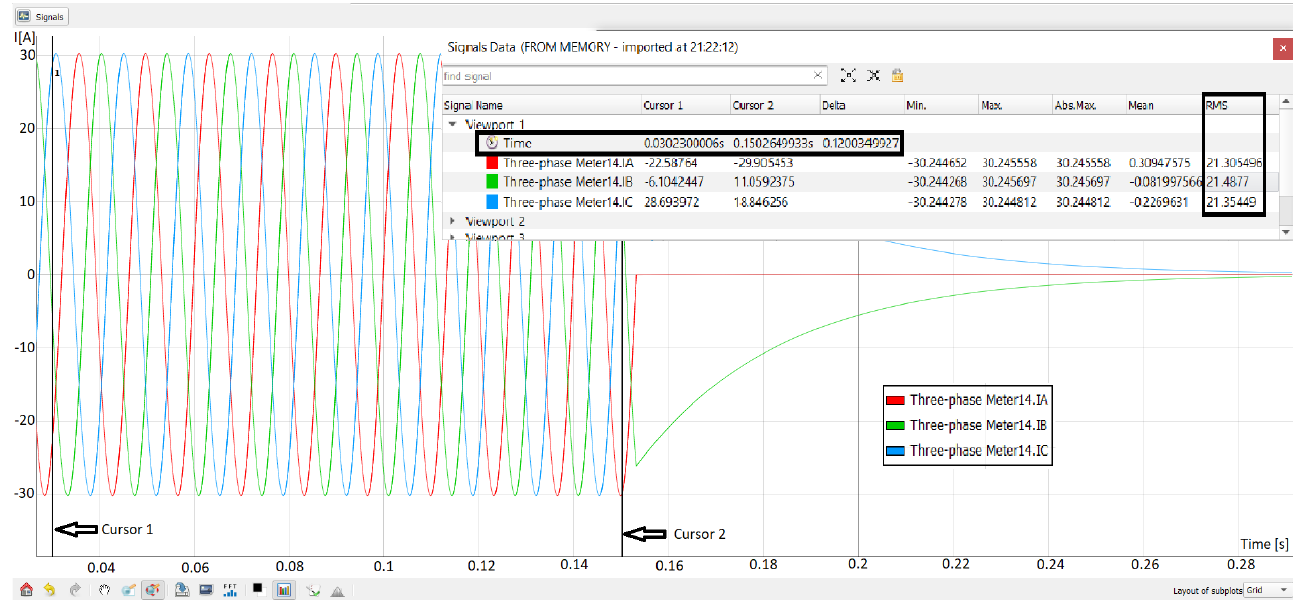
Figure 7. Fault current contribution response of IBDER connected to bus 14 during 3LG short-circuit at bus 9 in time domain obtained with Typhoon HIL setup.